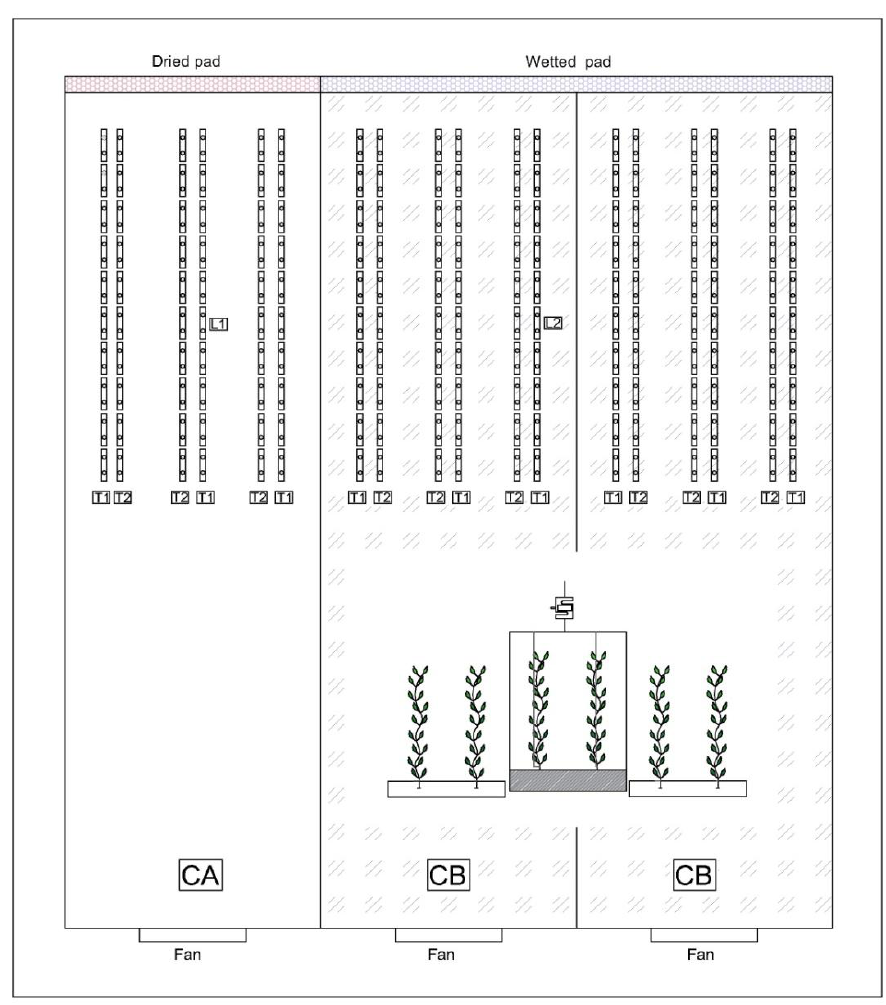
Figure 2. Layout of greenhouse separation into two compartments, positioning of the plants and measuring equipment (lysimeters); CA, compartment with fan ventilation cooling; CB, compartment with fan-pad evaporative cooling; L1, L2, lysimeters; T1, irrigation treatment 1 (0.32 L m −2 ); T2, irrigation treatment 2 (0.24 L m −2 ).